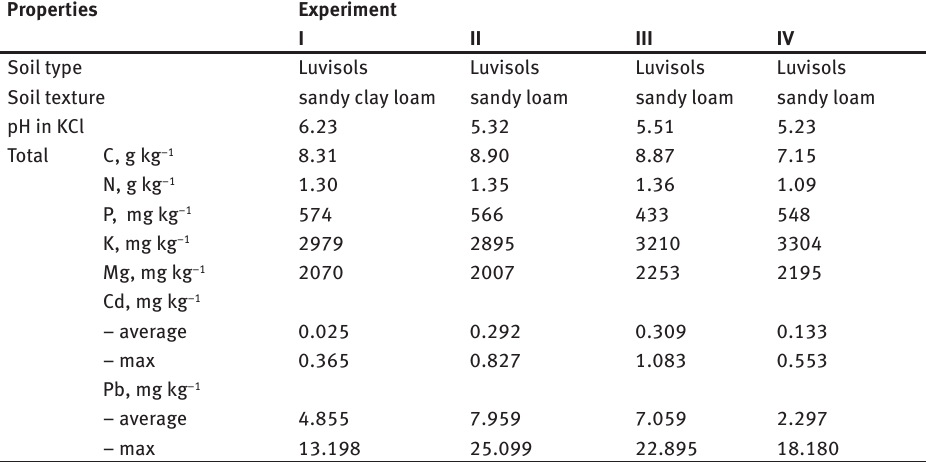
Table 3: Soil characteristic before the start of the experiments. Properties